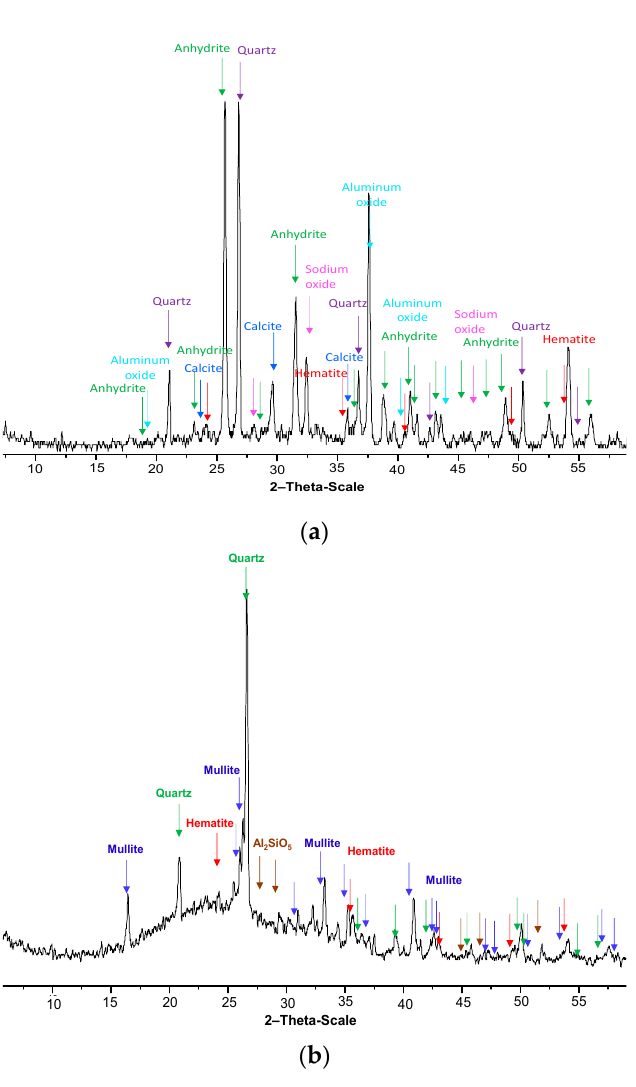
Figure 1. X Ray diffraction patterns: ( a ) Fly ash B (FAB); ( b ) Fly ash R (FAR). Table 1. Chemical composition of fly ash B (FAB).